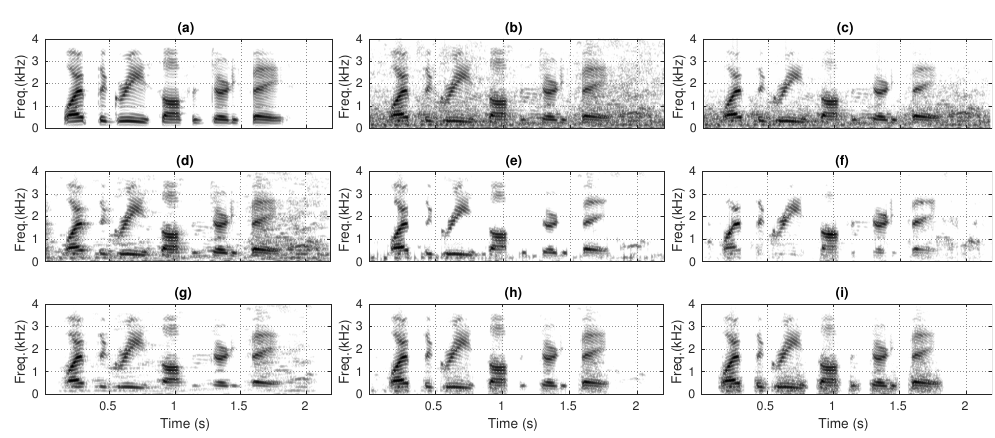
Figure 11. Comparing the spectrograms of: ( a ) clean speech (utterance sp05), ( b ) noisy speech (corrupt sp05 with 5 dB babble noise) (PESQ = 2.10), enhanced speech produced by the: ( c ) KF-non- oracle (PESQ = 2.18), ( d ) MMSE-STSA [9] (PESQ = 2.32), ( e ) AKF-IT [13] (PESQ = 2.26), ( f ) AKF- RMBT [22] (PESQ = 2.42), ( g ) MDKF-MMSE (PESQ = 2.48), ( h ) proposed (PESQ = 2.55), and ( i ) KF- nracle (PESQ = 2.61) methods.